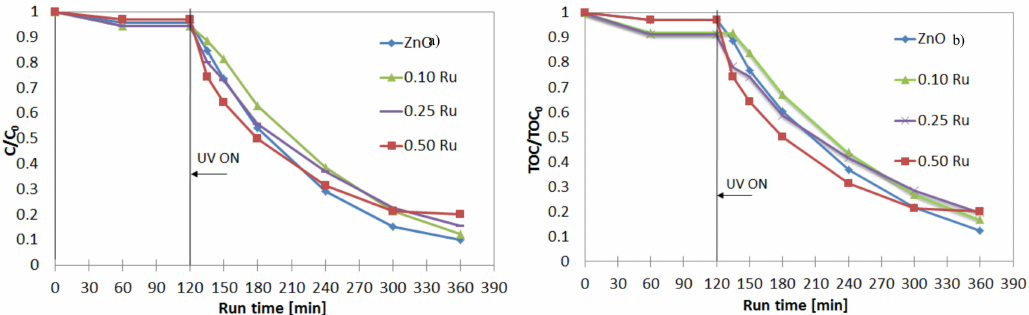
Figure 5. E ff ect of the Ru content on methyl orange (MO) discoloration ( a ) and mineralization ( b ) during the run